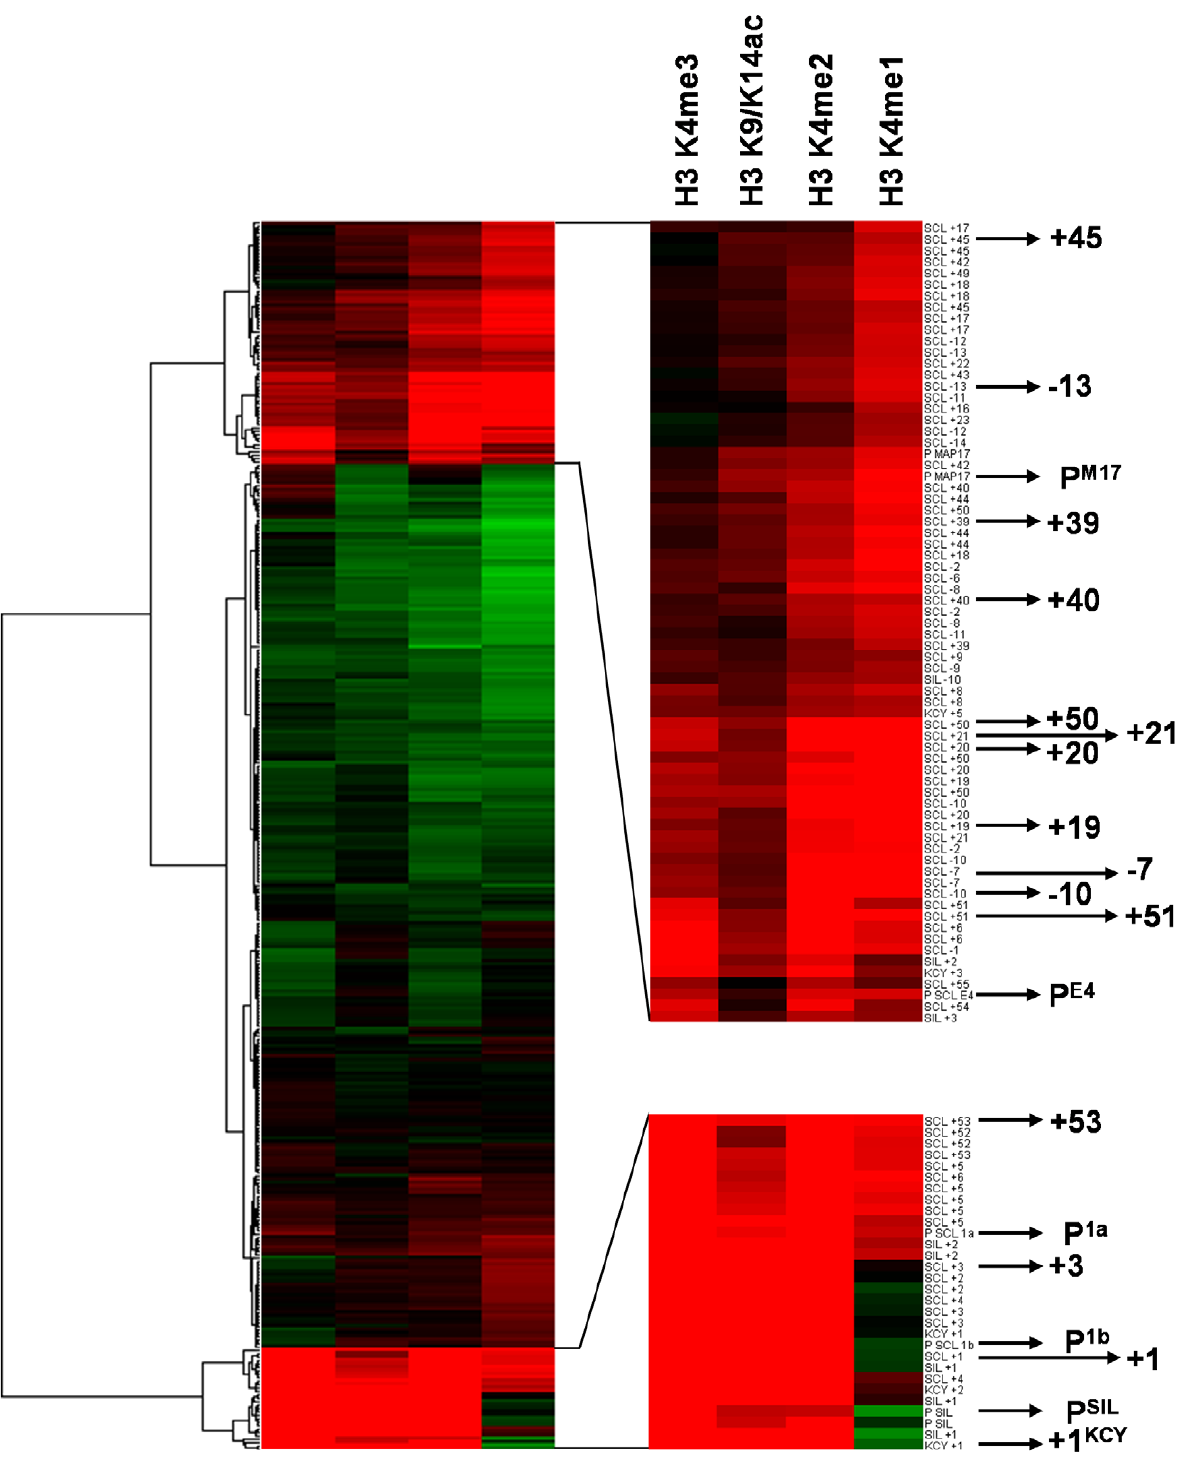
Figure 3. Treeview diagram of hierarchical clustering of genomic tiles across the human SCL locus for histone modifications in the K562 cell line. Each tile is represented by a horizontal bar and is shaded in red scale or green scale to denote level of enrichment or depletion respectively. The tree diagram is shown to the left of the figure. Two branches of the tree and the histone modifications studied are shown in the enlarged panel to the right of the figure. Each genomic tile in the enlarged panel is named according to its distance in kb relative to SCL pro1a or to the promoter of its closest known gene. Tiles representing SCL known and novel regulatory elements are denoted by an arrow and highlighted in bold.